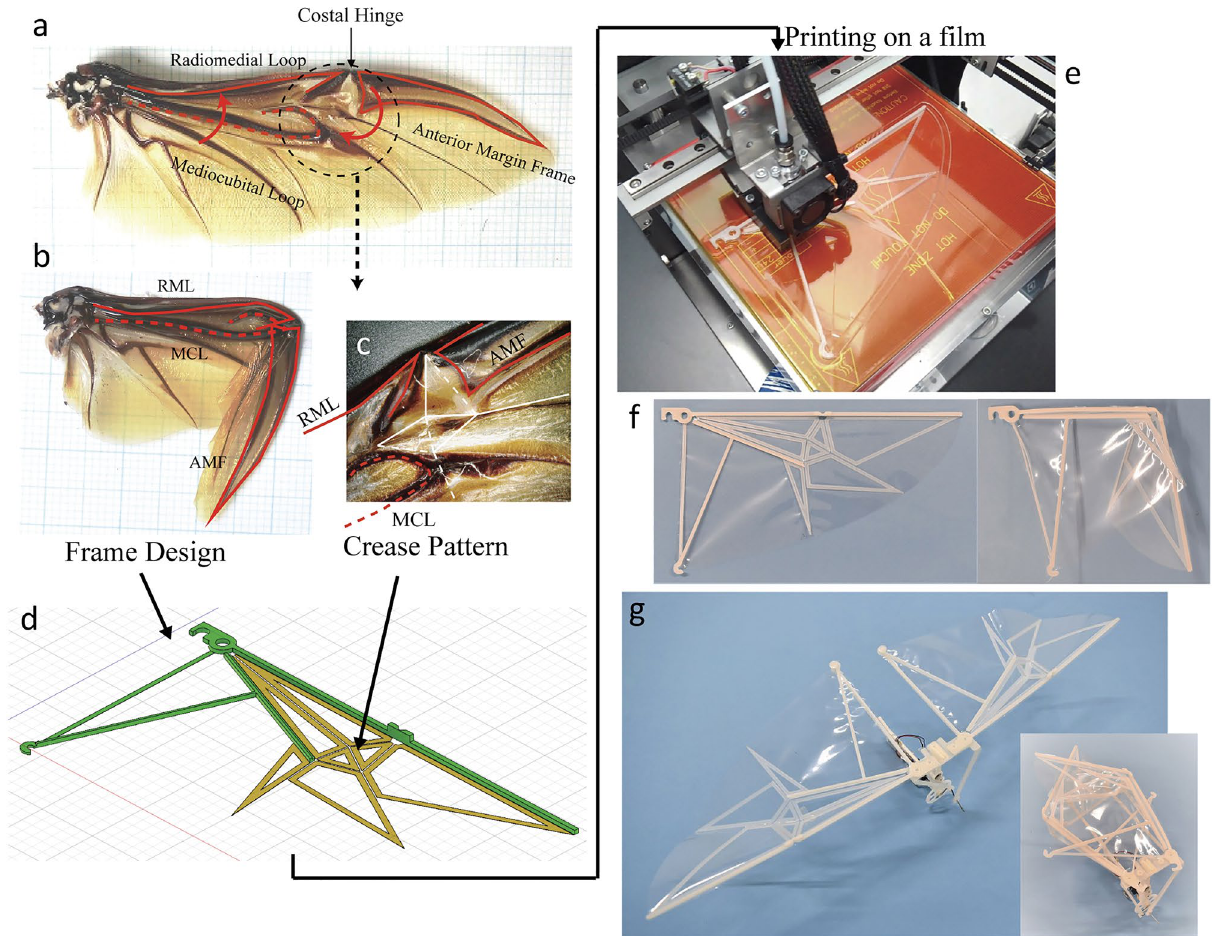
Figure 2. Design of the beetle inspired foldable wing. ( a , b ) Hindwing in a Japanese horn beetle. Wing is supported with three main frames. ( c ) Main crease pattern found at the center of the wing. ( d ) 3D model of designed foldable wing. Frames (green) are designed based on above three main frames. Crease patterns are introduced by reinforcing facets with 0.1 mm clearance (yellow). ( e ) 3D printing of wing structures on PP film. ( f , g ) 3D printed foldable wings and flapping